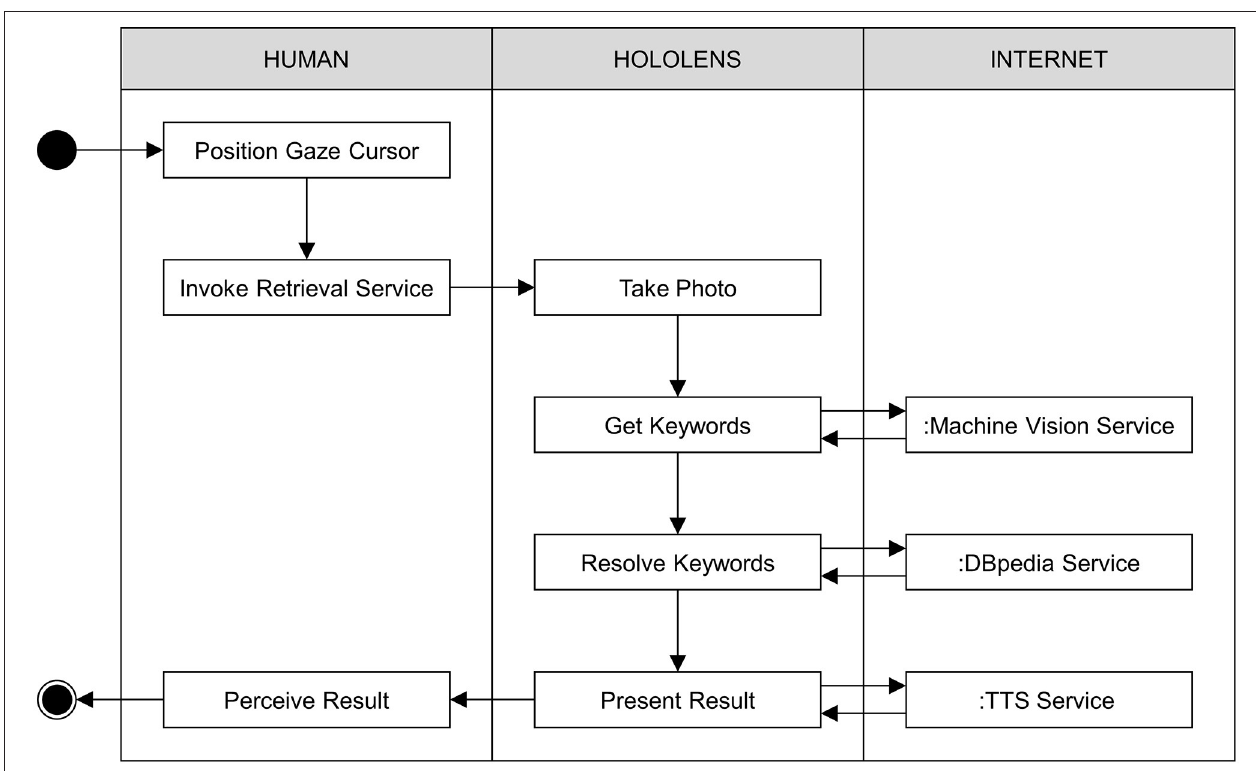
FIGURE 2 | Swim lane diagram showing the distribution of activities between the human user, the HoloLens device, and online services in the case of the HoloArt app. Together, the individual steps of this routine comprise the painting recognition process.